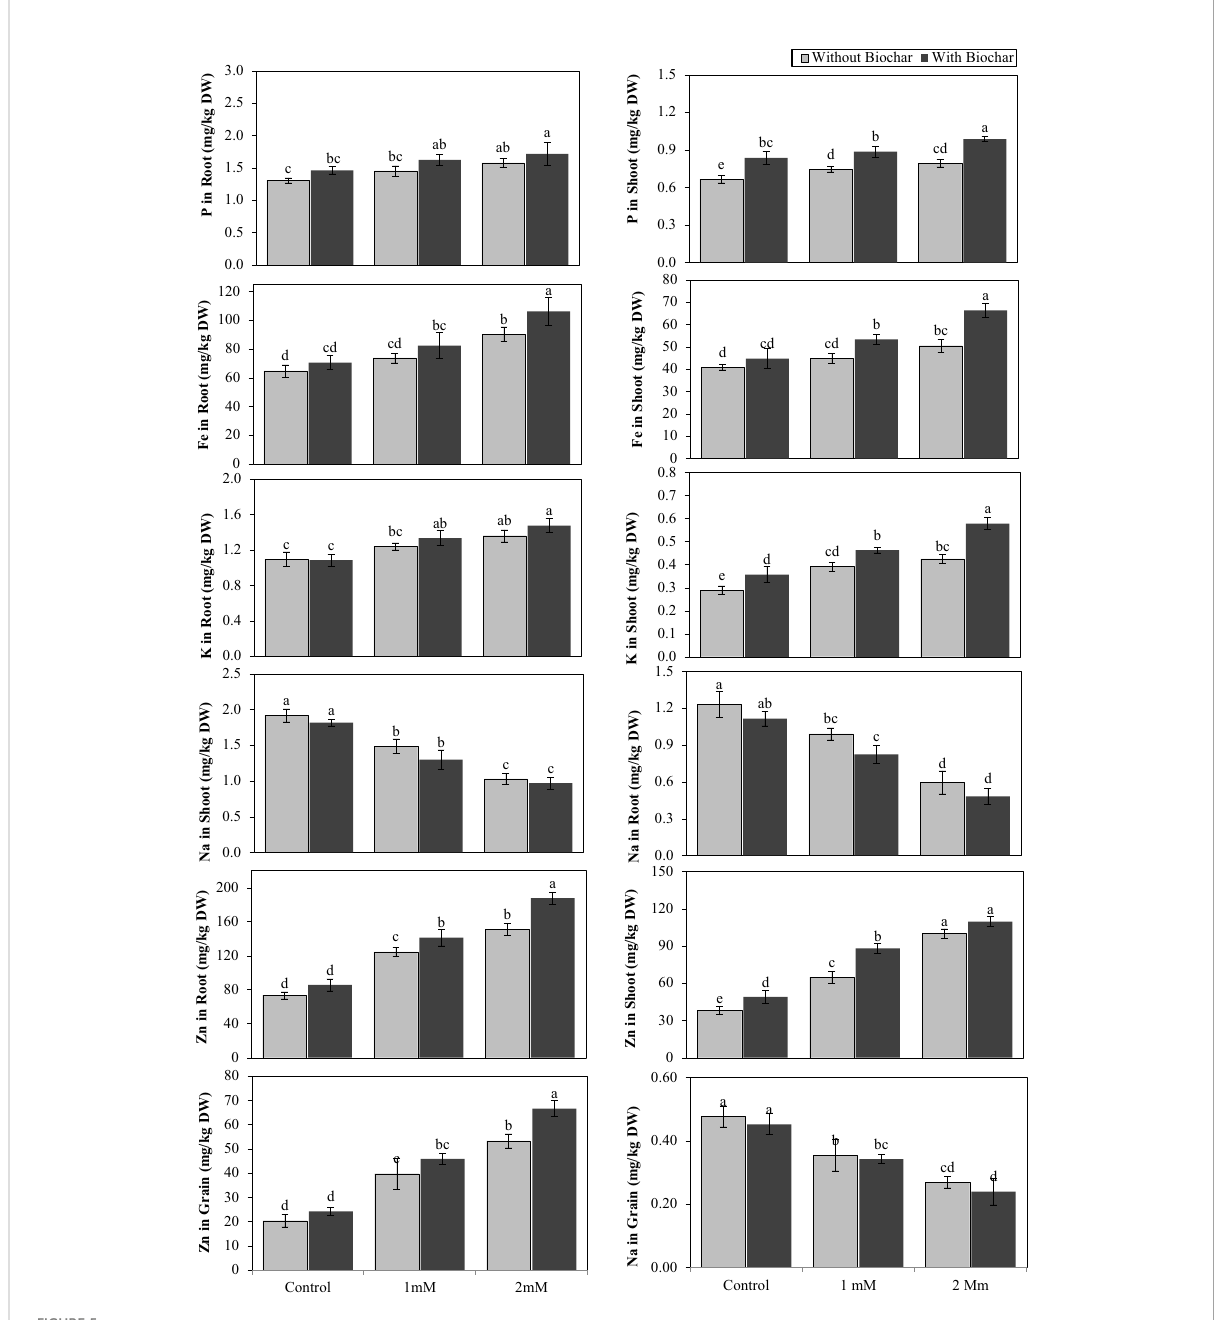
FIGURE 5 Data represented different levels of zinc-lysine (Control 0, 1, 2 mM) along with and without biochar on P in shoot, P in root, Fe in 638 root, Fe in shoot, K in root, K in shoot, Na in root, Na in shoot, Zn in root, Zn in shoot, Zn in grain, Na in grain of wheat plant showed means 639 of replicates (n=3) ± standard deviation. Different letters indicate signi fi cant differences by Tukey HSD test at p ≤